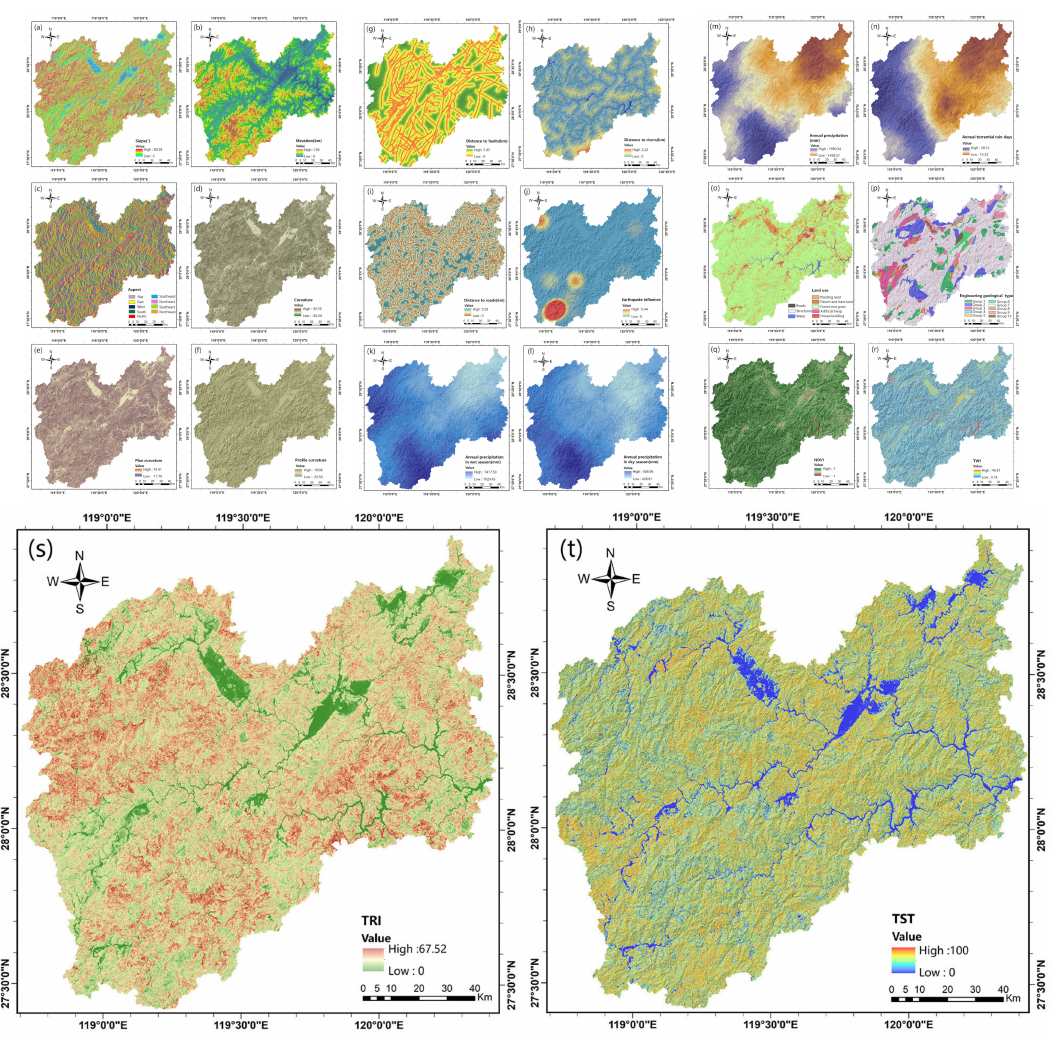
Figure 3. Thematic maps of the landslide-causing factors: ( a ) slope; ( b ) elevation; ( c ) aspect; ( d ) curvature; ( e ) plan curvature elevation; ( f ) profile curvature; ( g ) distance to faults; ( h ) distance to rivers; ( i ) distance to roads; ( j ) earthquake influence; ( k ) annual precipitation in the wet season; ( l ) annual precipitation in the dry season; ( m ) annual precipitation; ( n ) annual torrential rain days; ( o ) land use; ( p ) engineering geological type; ( q ) NDVI; ( r ) TWI; ( s ) TRI; and ( t )